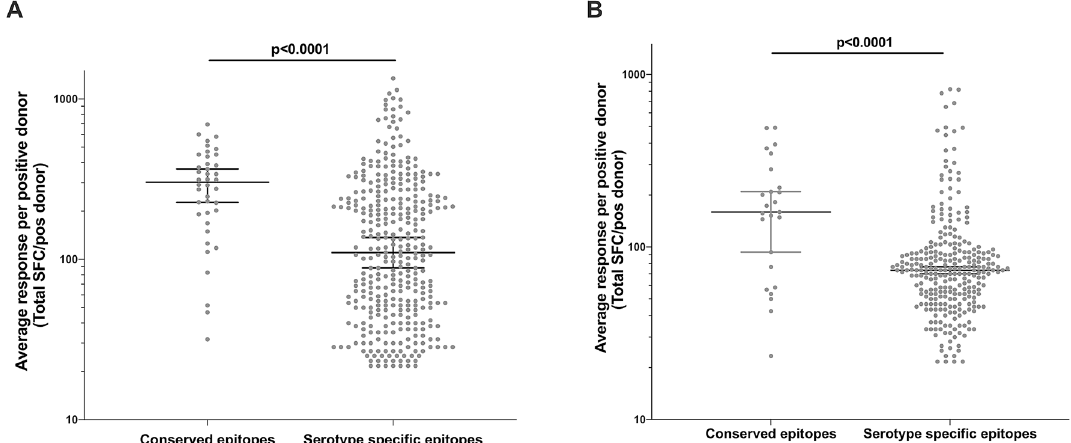
Figure 4. High magnitude of CD8 + T cell responses against conserved epitopes. ( A ) Comparison of the magnitude of IFN-γ responses from CD8 + T cells targeting highly conserved epitopes, and serotype specific epitopes identified in the Sri Lanka ( A ) and Nicaragua ( B ) datasets. Shown are dot plots with Spot Forming Counts (SFC)/10 6 PBMCs normalized by the number of subjects with a positive response against the targeted epitope. Horizontal bars represent median values with 95% confidence